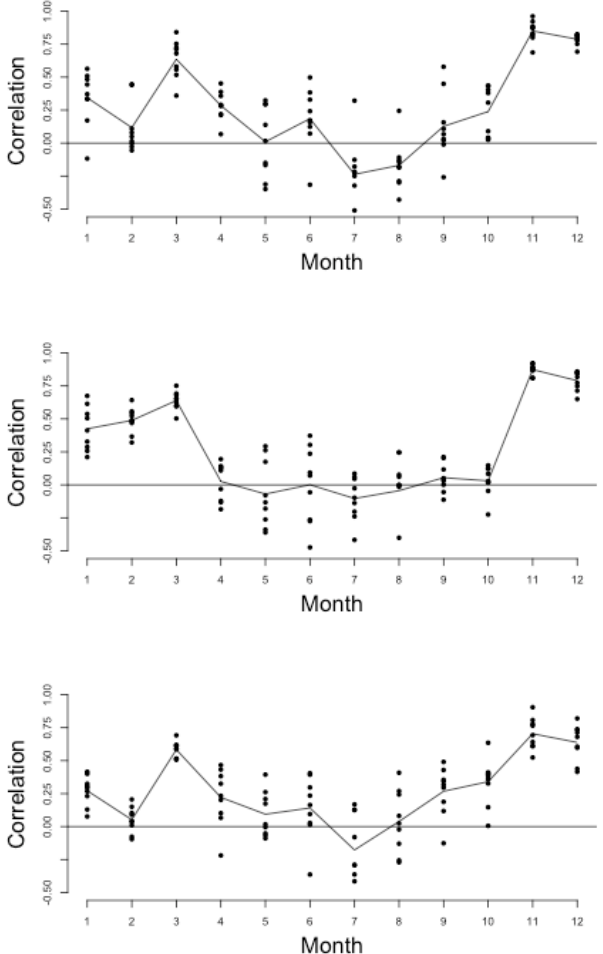
Figure 3. Interannual correlation between monthly mean rainfall and monthly mean beta for (from top to bottom) Chikanta, Magoye, Makafu. The dots are for individual ensemble rainfall realizations and the black line is mean correlation.